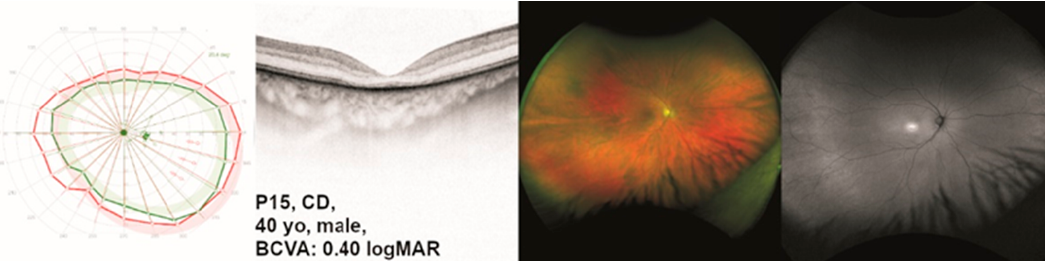
Figure 4. Clinical presentation of patient P15 with TULP1 -associated cone dystrophy (CD). The results of kinetic visual field (VF) testing, optical coherence tomography (OCT), fundus photography, and fundus autofluorescence (FAF) imaging are shown from left to right. Gender and best-corrected visual acuity (BCVA) are also listed. Note the CD-typical findings in all shown modalities.